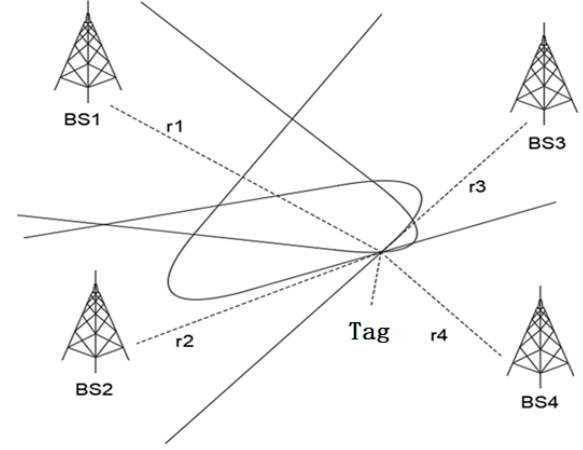
16 of 24 Figure 8. TDOA positioning principle.